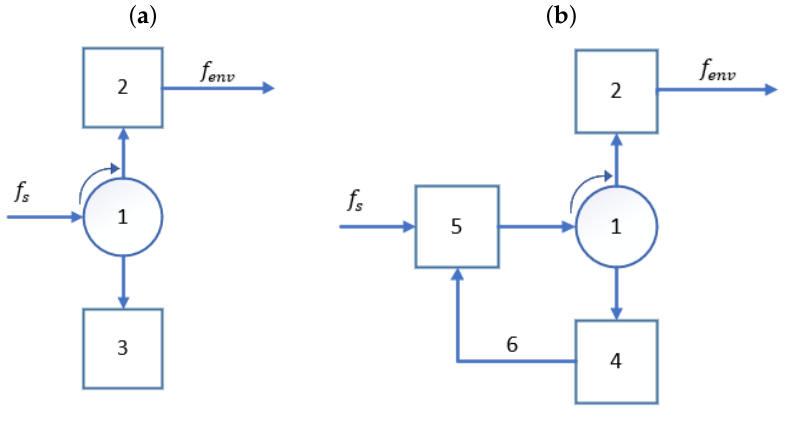
Figure 1. Block diagram of an autodyne receiver, where ( a ) without load, ( b ) with load. Autodyne systems allow for frequency conversion, control of amplitude-frequency and phase-frequency characteristics, as well as significant amplification of the signal caused by the circulator of autodyne vibrations. In addition, oscillations of the input signal are again directed to the circulator and used in the conversion, thus allowing the reduction in the associated losses. Despite the energy losses that occur in all mechanical systems, the self- excitation phenomenon can result in non-decaying periodic oscillations. In real systems, the self-excitation phenomenon occurs in cutting tools, turbine blades, aircraft airfoils and suspension bridges [37]. Even a small perturbation of a non-static equilibrium position can cause not only non-decaying but also ncreasing vibrations (Figure 2). Due to the nature of the limit cycle, there is a difference between soft and hard cycle oscillations. Soft oscillations occur when the phase trajectories follow a limit cycle. They are characterized by stable oscillations for which its amplitude tends towards the limit value. In the case of hard oscillation also known as catastrophic oscillation, the phase trajectories tend from the limit cycle to infinity. The amplitude of the oscillation infinitely increases, consequently resulting in the destruction of the oscillating object as in the case of the Tacoma Bridge in the USA [38].